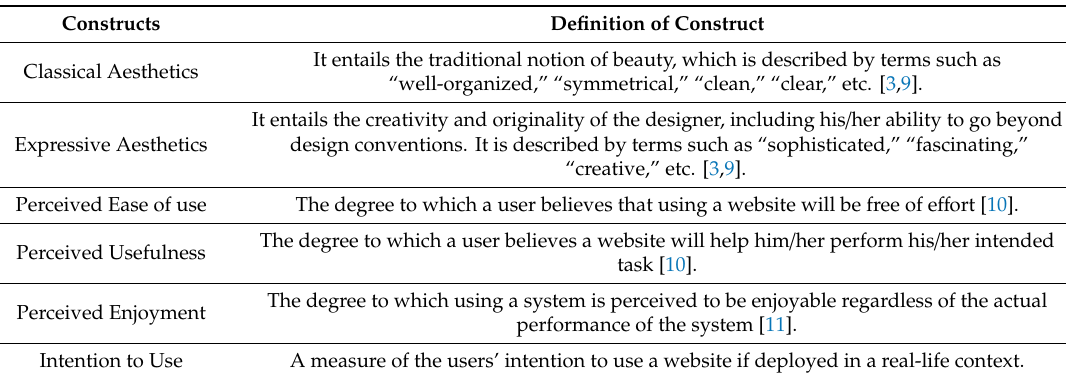
Table 1. Overview of technology acceptance model (TAM)-based UX design